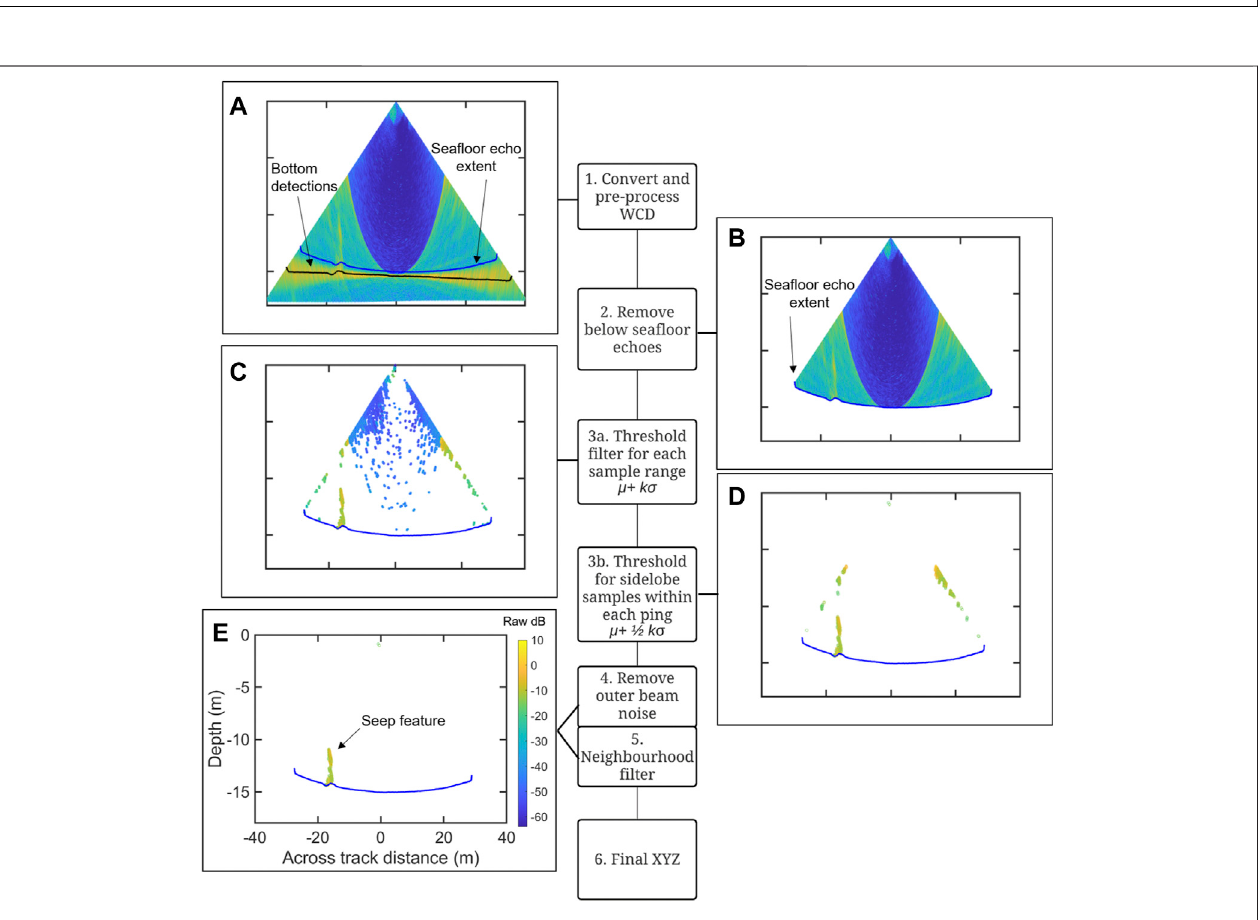
FIGURE 3 | Overview of the pre-processing and fi ltering work fl ow steps. Images correspond to a single ping with targets comprising a seep feature within the MSR B region. These show the results of applying the corresponding fi ltering step(s) in sequence. The color scale represents raw dB values ranging from − 64 to 10 dB. The black line in the top image (A) shows the original bottom detections. The blue line (B – E) is the modelled extent of the sea fl oor echoes.